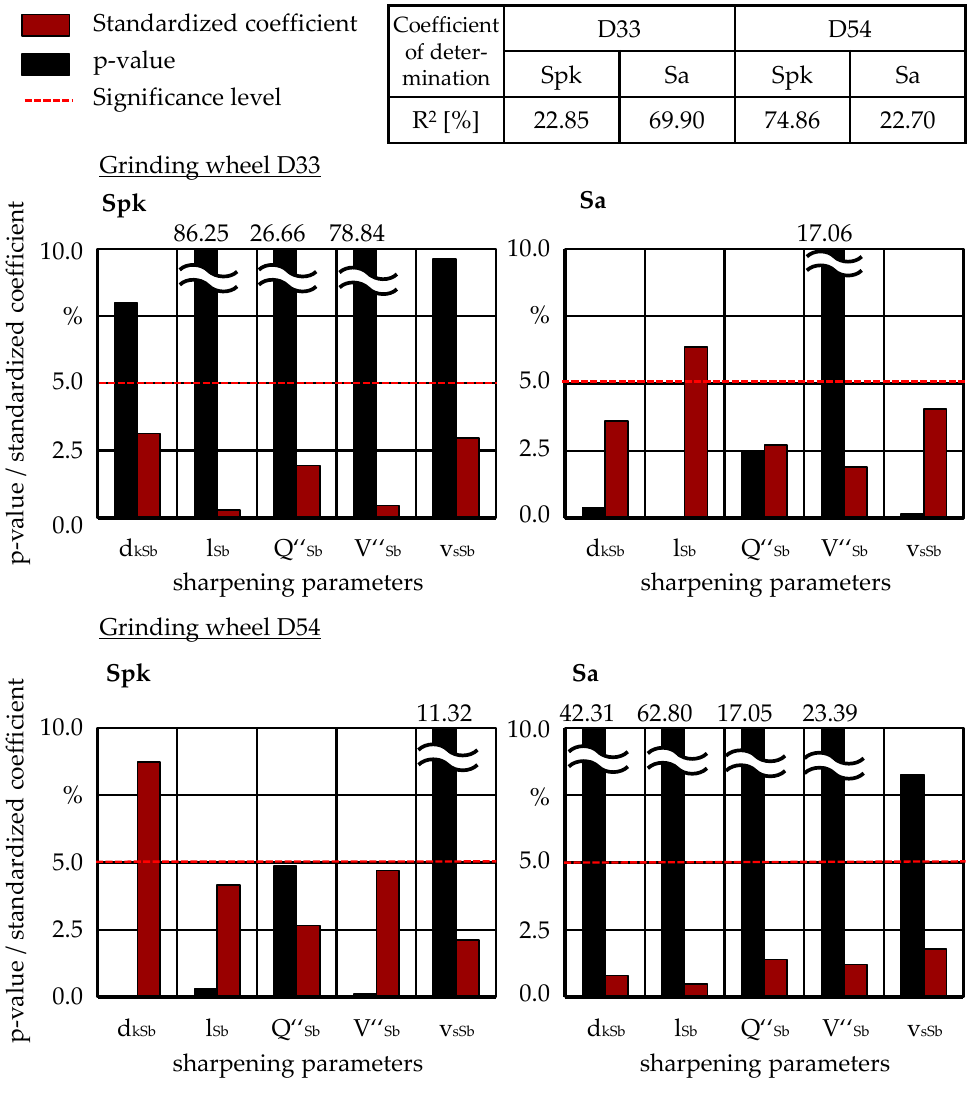
Figure 3. Significance analysis for the topography characteristics, the reduced peak height Spk and the mean arithmetic height Sa.